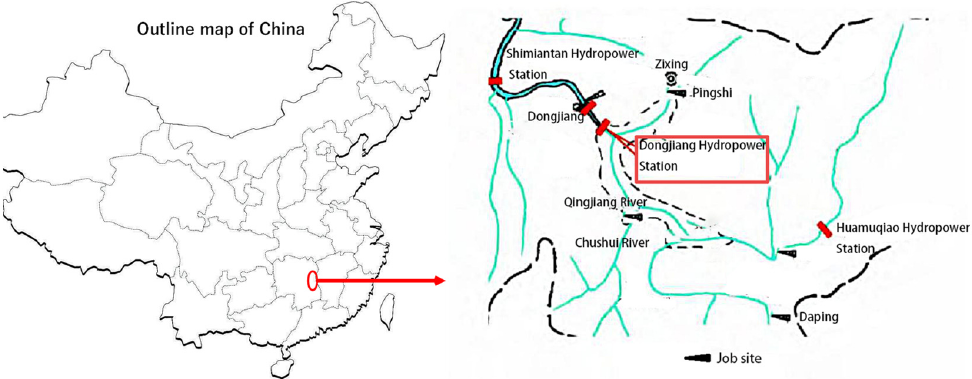
Figure 6. Dongjiang River Basin Map.